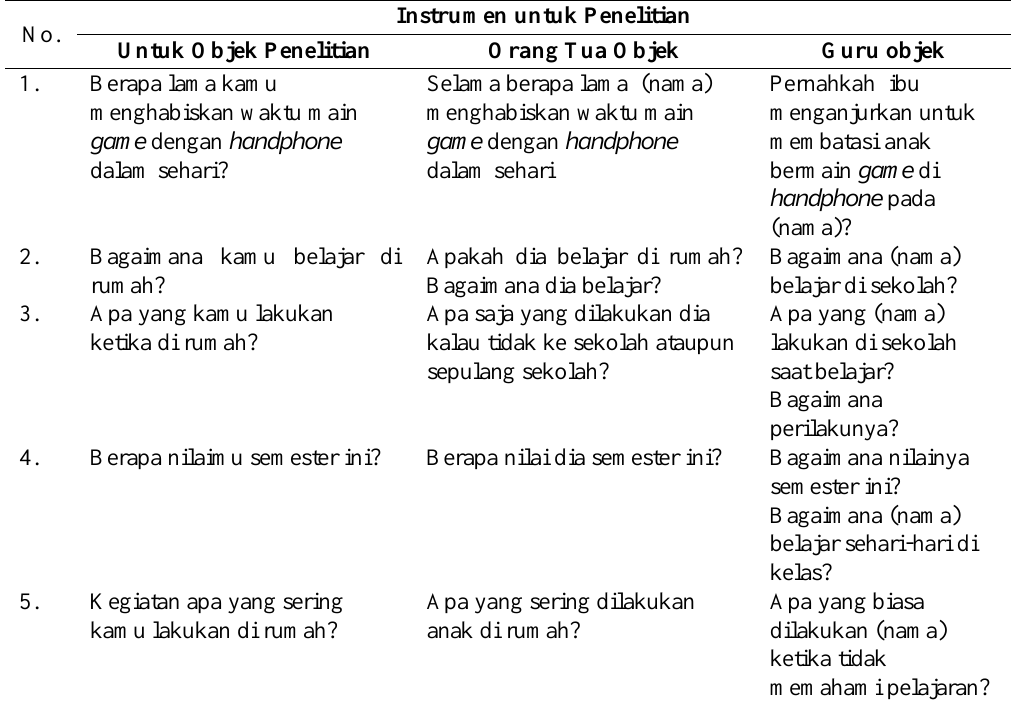
Tabel 1. Instrumen Dasar